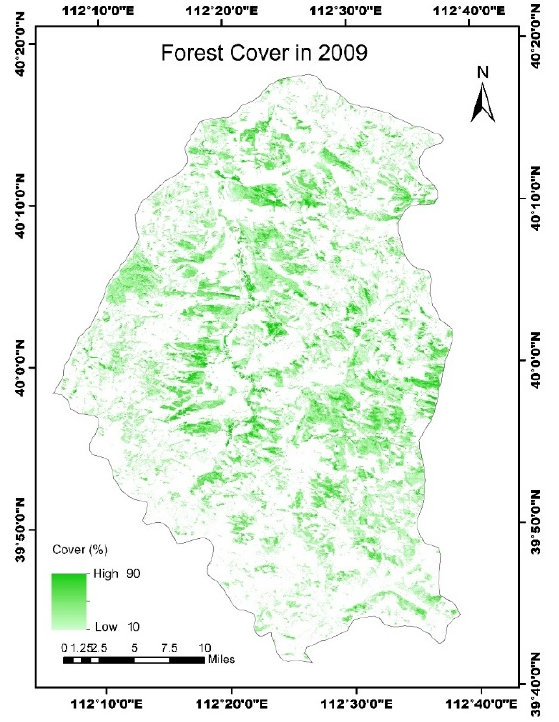
Figure 3. Sub-pixel forest cover estimated from airborne LiDAR data in 2009.